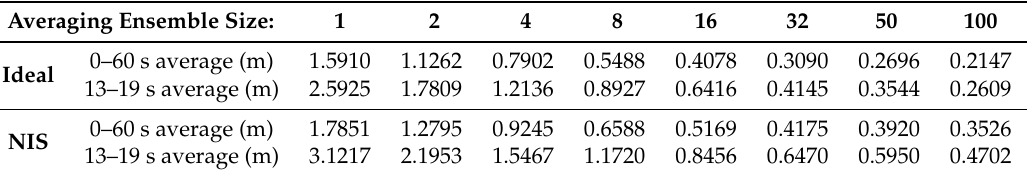
Table 3. 95-percentile horizontal